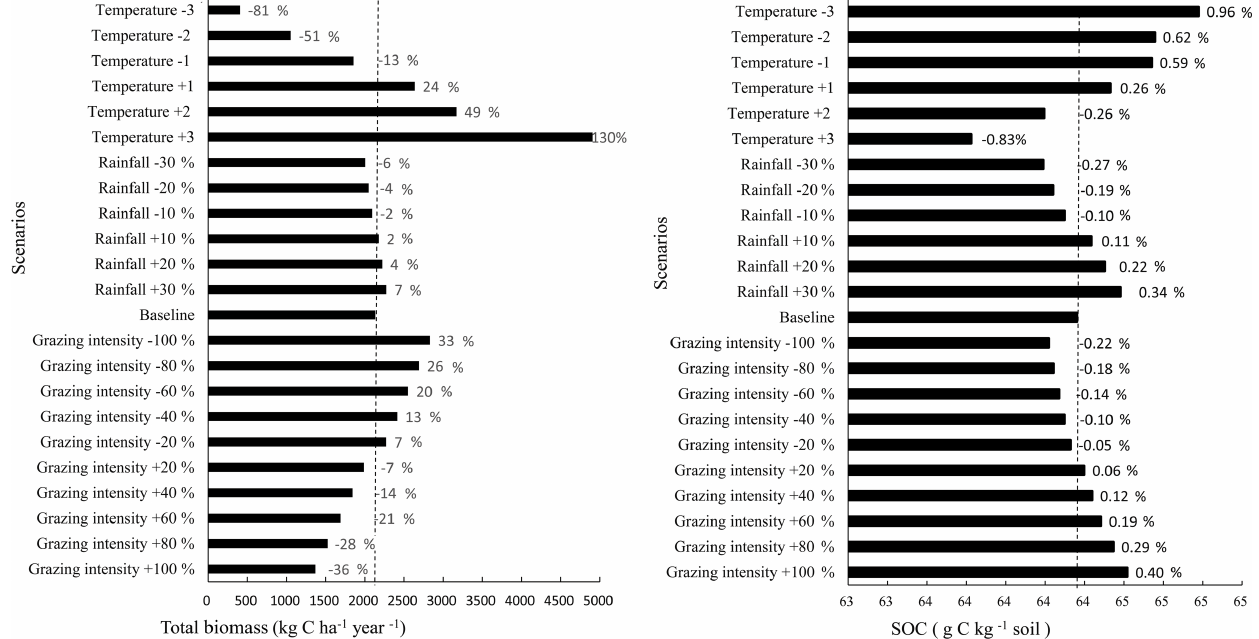
Figure 4. Sensitivity analysis of model response to climate and grazing intensity change. The baseline biomass and SOC were the average value of a 55-year (1961–2014) simulation based on the actual climate and grazing conditions in the study area. Table 2. Summary of two-way analysis of variance for biomass and SOC relative to the climate, grazing intensity, and their interactions during 1985–2044. Degrees of freedom (d.f.), mean squares (M.S.), variance ratio ( F value), and level of significance ( P value) are shown. Source of variation d.f. Biomass SOC M.S. F value P value M.S. F value P value Climate 2 16827.91 54.27 ∗ 468.16 723.54 ∗ Grazing intensity 3 22132.64 71.37 ∗ 17.29 26.72 ∗ Climate × grazing intensity 6 2.63 0.01 n.s. 0.28 0.28